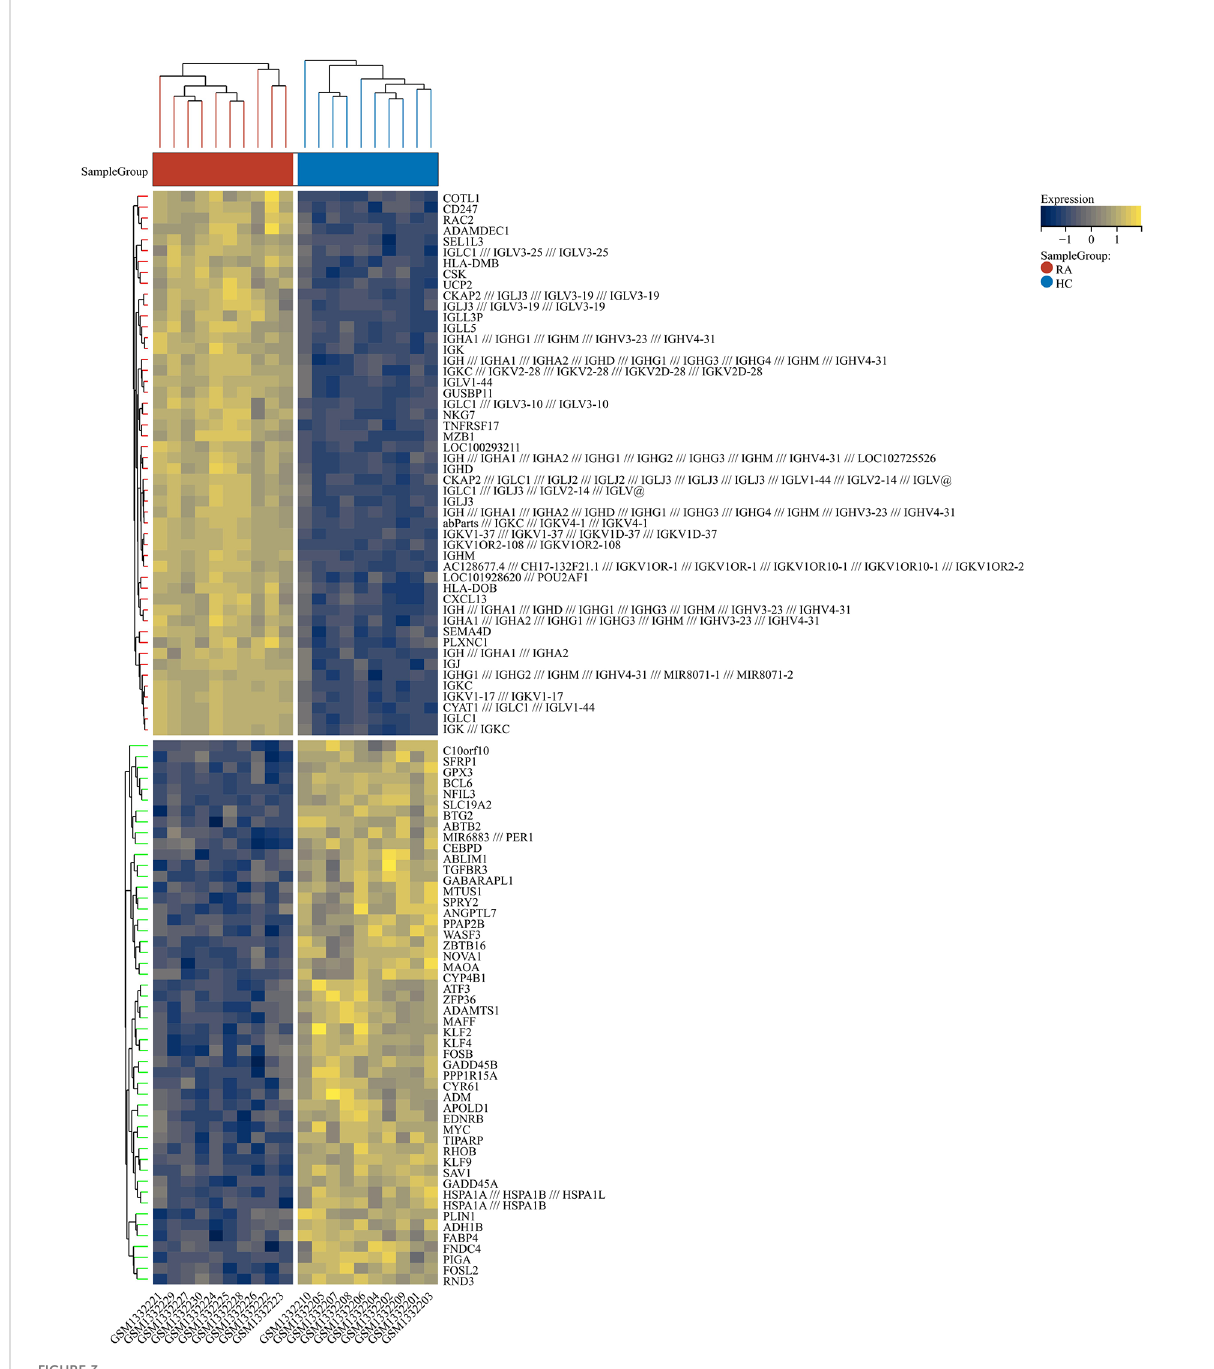
FIGURE 3 RA-DEGs distribution. The Clustering heat map displays the top one hundred DEGs from the GSE55235 dataset. The samples from the RA group were colored red, while those from the HC group were colored blue. Yellow rectangles represent highly expressed genes ( P < 0.05), while blue rectangles represent lowly expressed genes ( P <